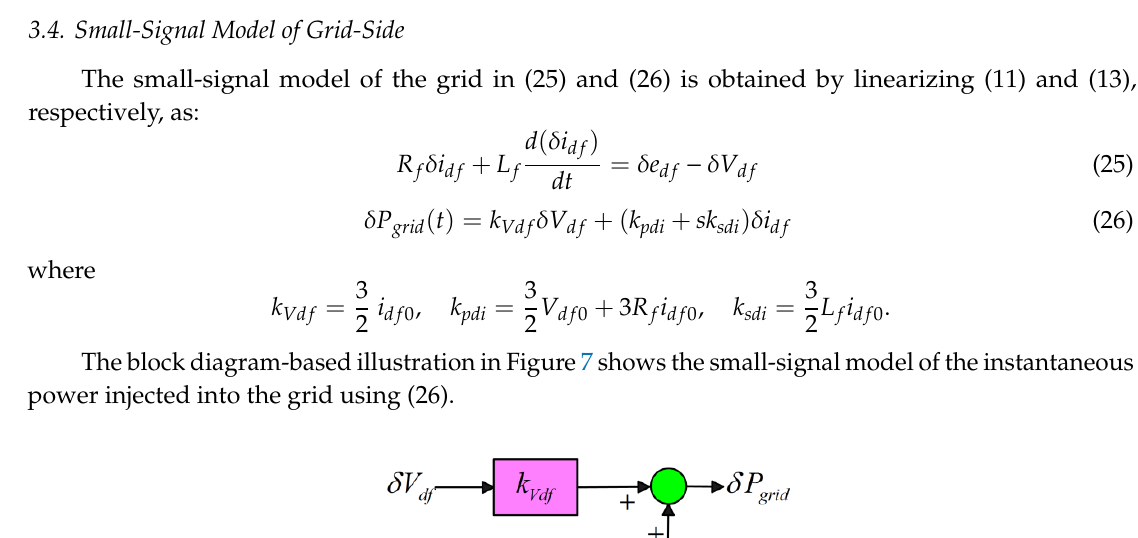
Figure 6. Small-signal block diagram of dc-link voltage.